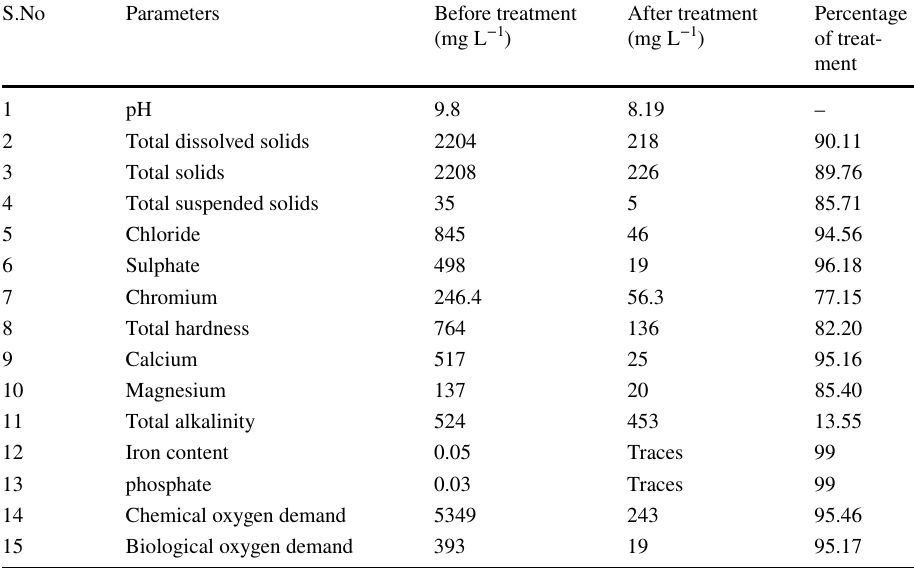
Table 1 Physiochemical characteristics of untreated and treated tannery wastewater using Chlorella